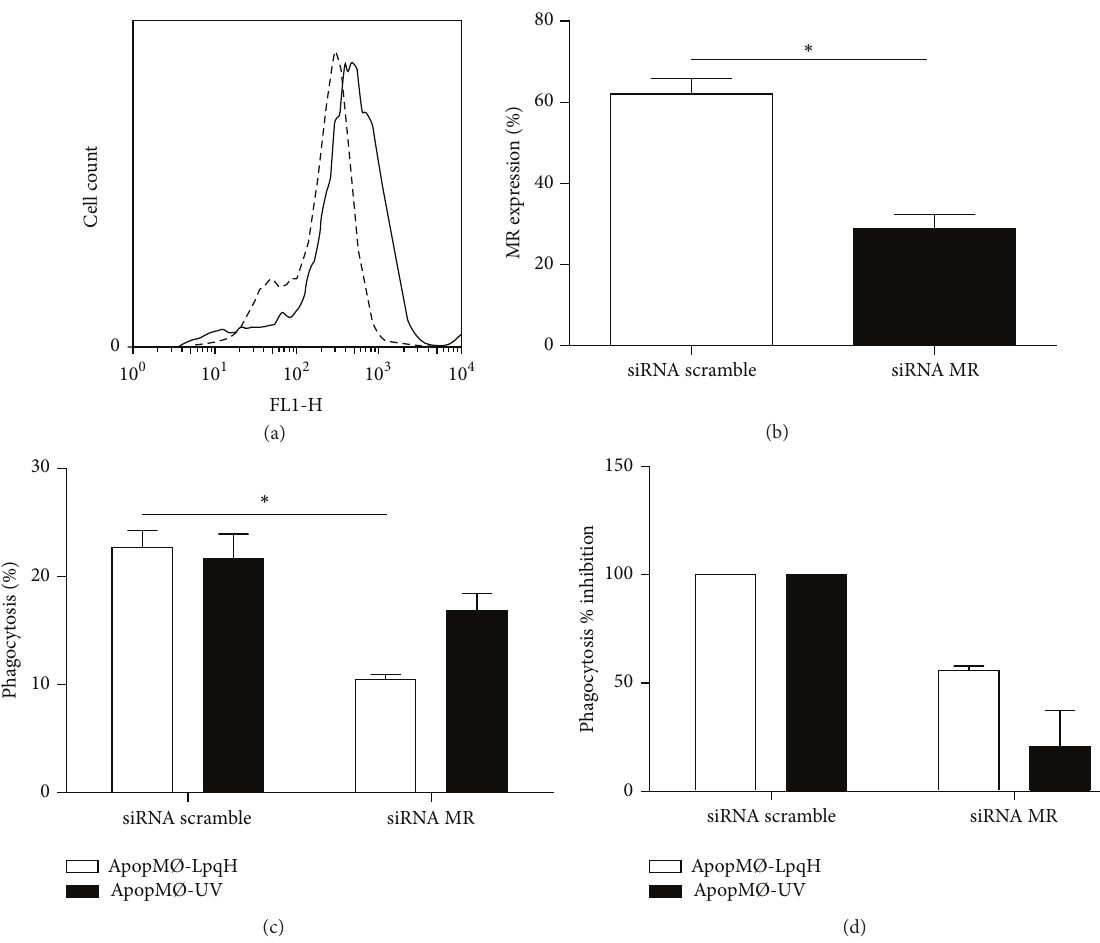
Figure 6: Mannose receptor specific small interference RNA decreases mannose receptor expression and the phagocytosis of apoptotic cells. J-774A.1 cells were transfected with siRNA specific for the MR for 64h. The expression of the MR and the phagocytic ability of cells transfected with siRNA MR and with a scrambled control are shown. The cell surface expression of the MR was assessed by flow cytometry. In a representative histogram (a) the inhibition induced is shown (dashed lines). In comparison with the MR expression of cells treated with scramble siRNA, MR-specific siRNA reduced significantly MR expression (b). Compared with cells treated with scrambled sRNA, phagocytosis of apoptotic cells was significantly reduced in MØs transfected with specific siRNA expressed as the percent of phagocytic cells (c) or the percent inhibition of the phagocytosis (d). The results of three independent experiments are presented. The statistical significance was assessed by one-way ANOVA, unpaired 𝑡 -test, Student’s 𝑡 -test, and nonparametric Kruskal-Wallis test; ∗ 𝑝 < 0.05